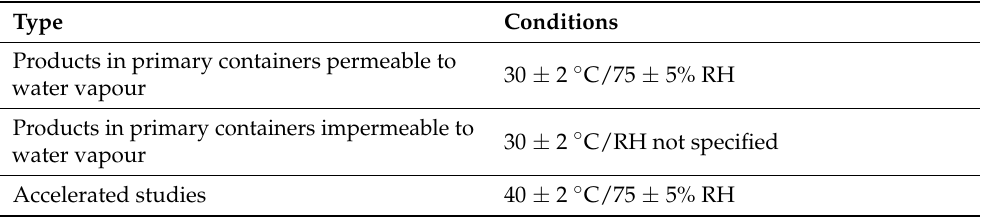
Table 1. Stability testing conditions in ASEAN